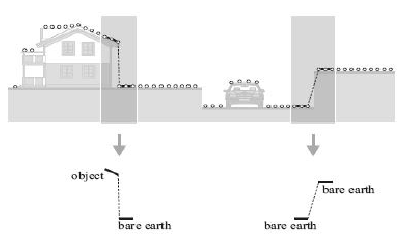
Figure 1. Miscarriage of justice cases of the traditional filtering